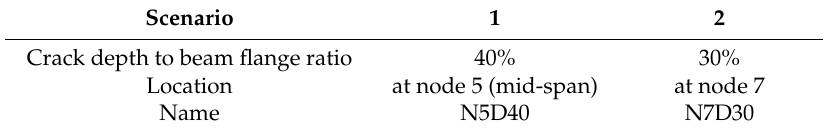
Table 2. Two damage scenarios considered in the laboratory model of the simply supported beam. Scenario